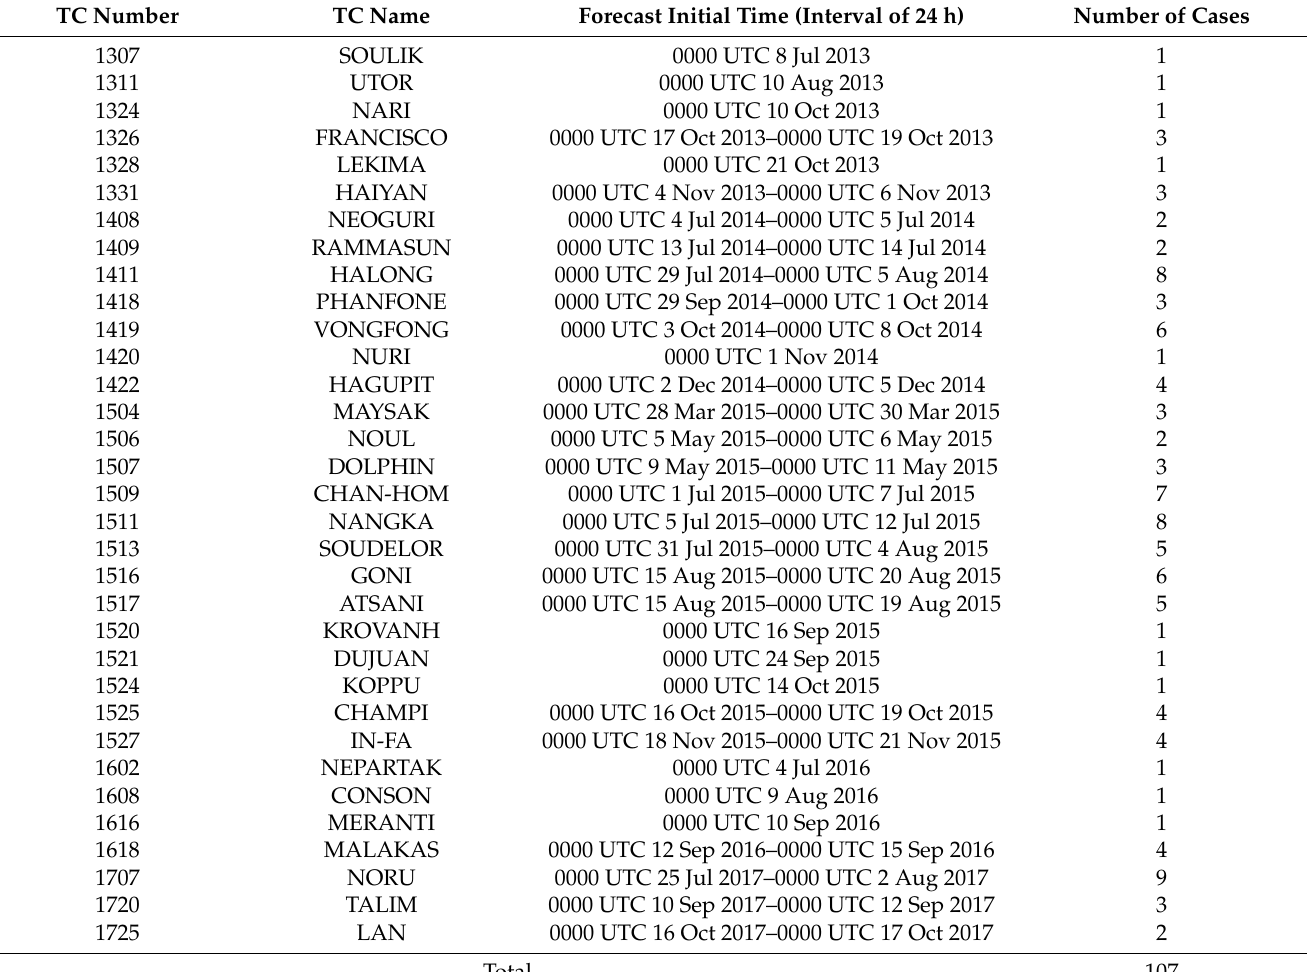
Table 1. Forecast details and initial times for the 33 TCs, which occurred from 2013 to 2017. The interval of forecast initial time is 24